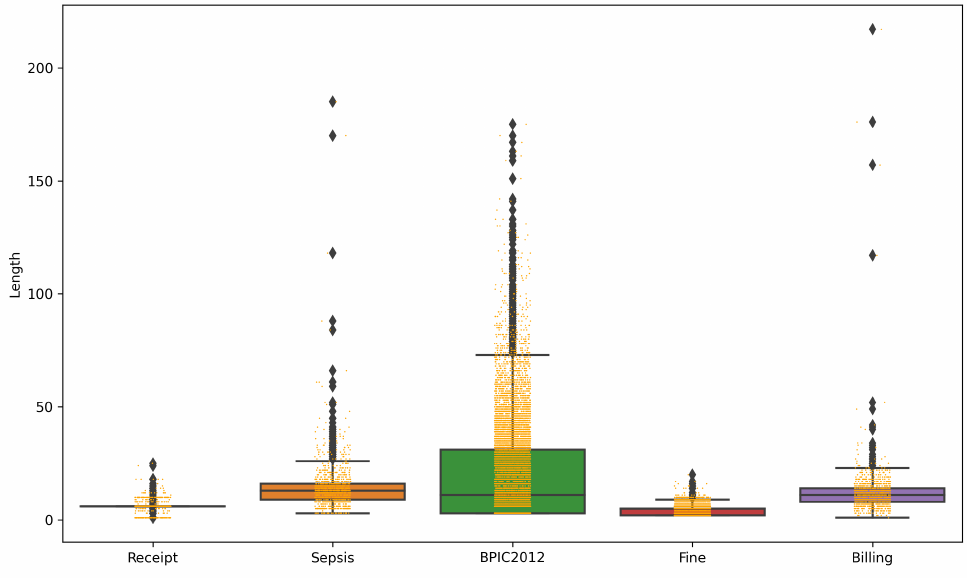
Figure 3. Distribution of trace lengths in the